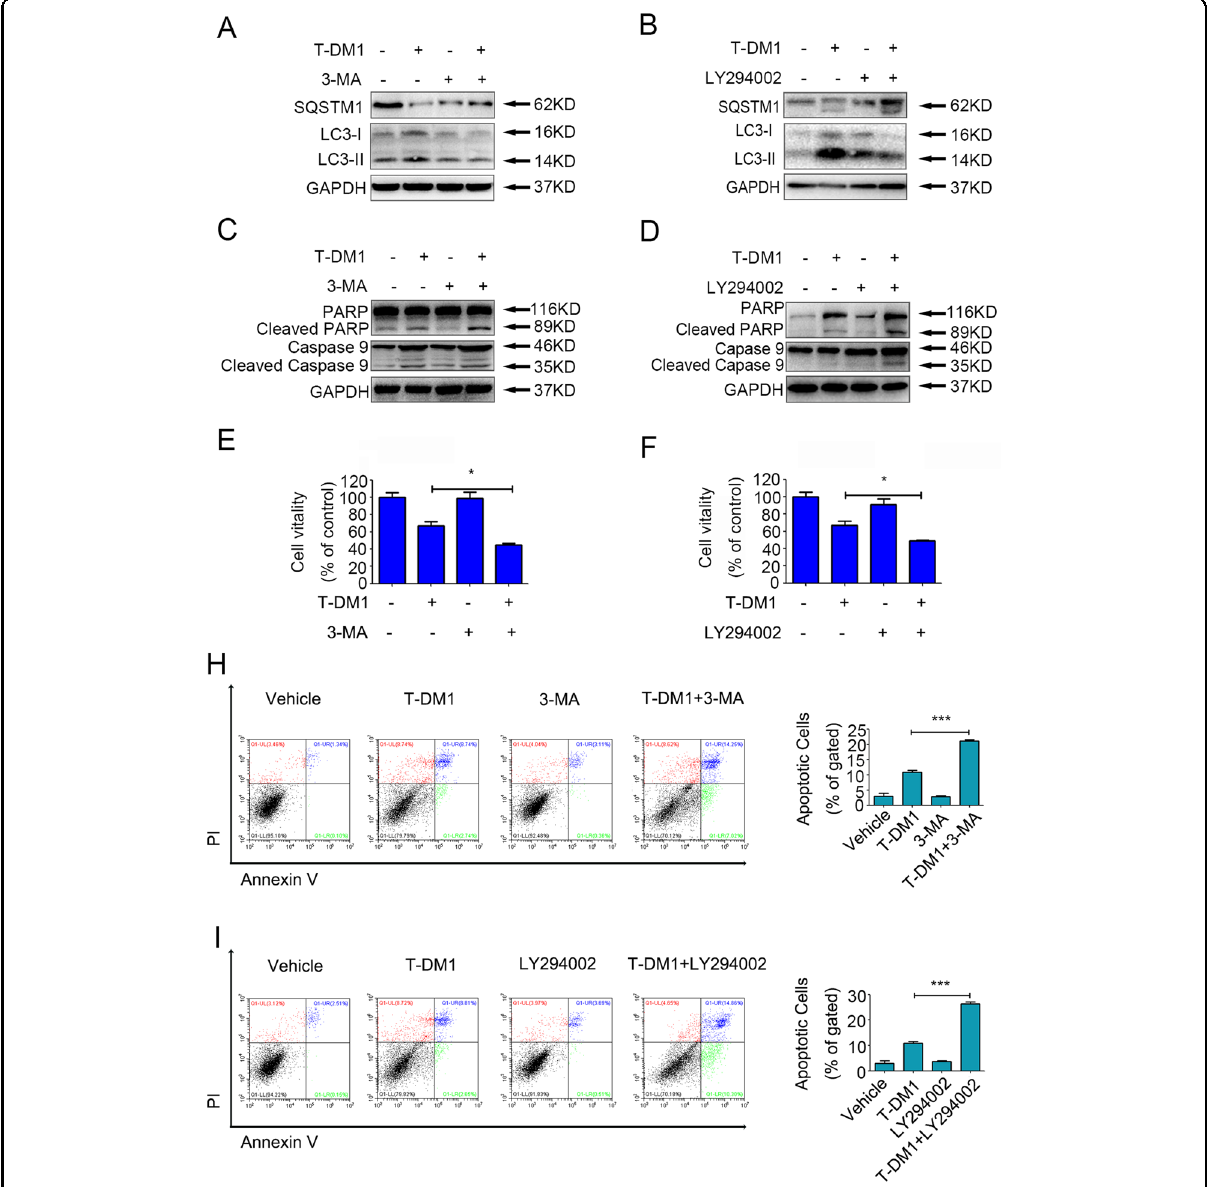
(0.31 μ g/ml) with the autophagic inhibitor 3-MA or LY294002 in NCI-N87 cells were measured by FCM. Apoptotic cells were stained with Annexin